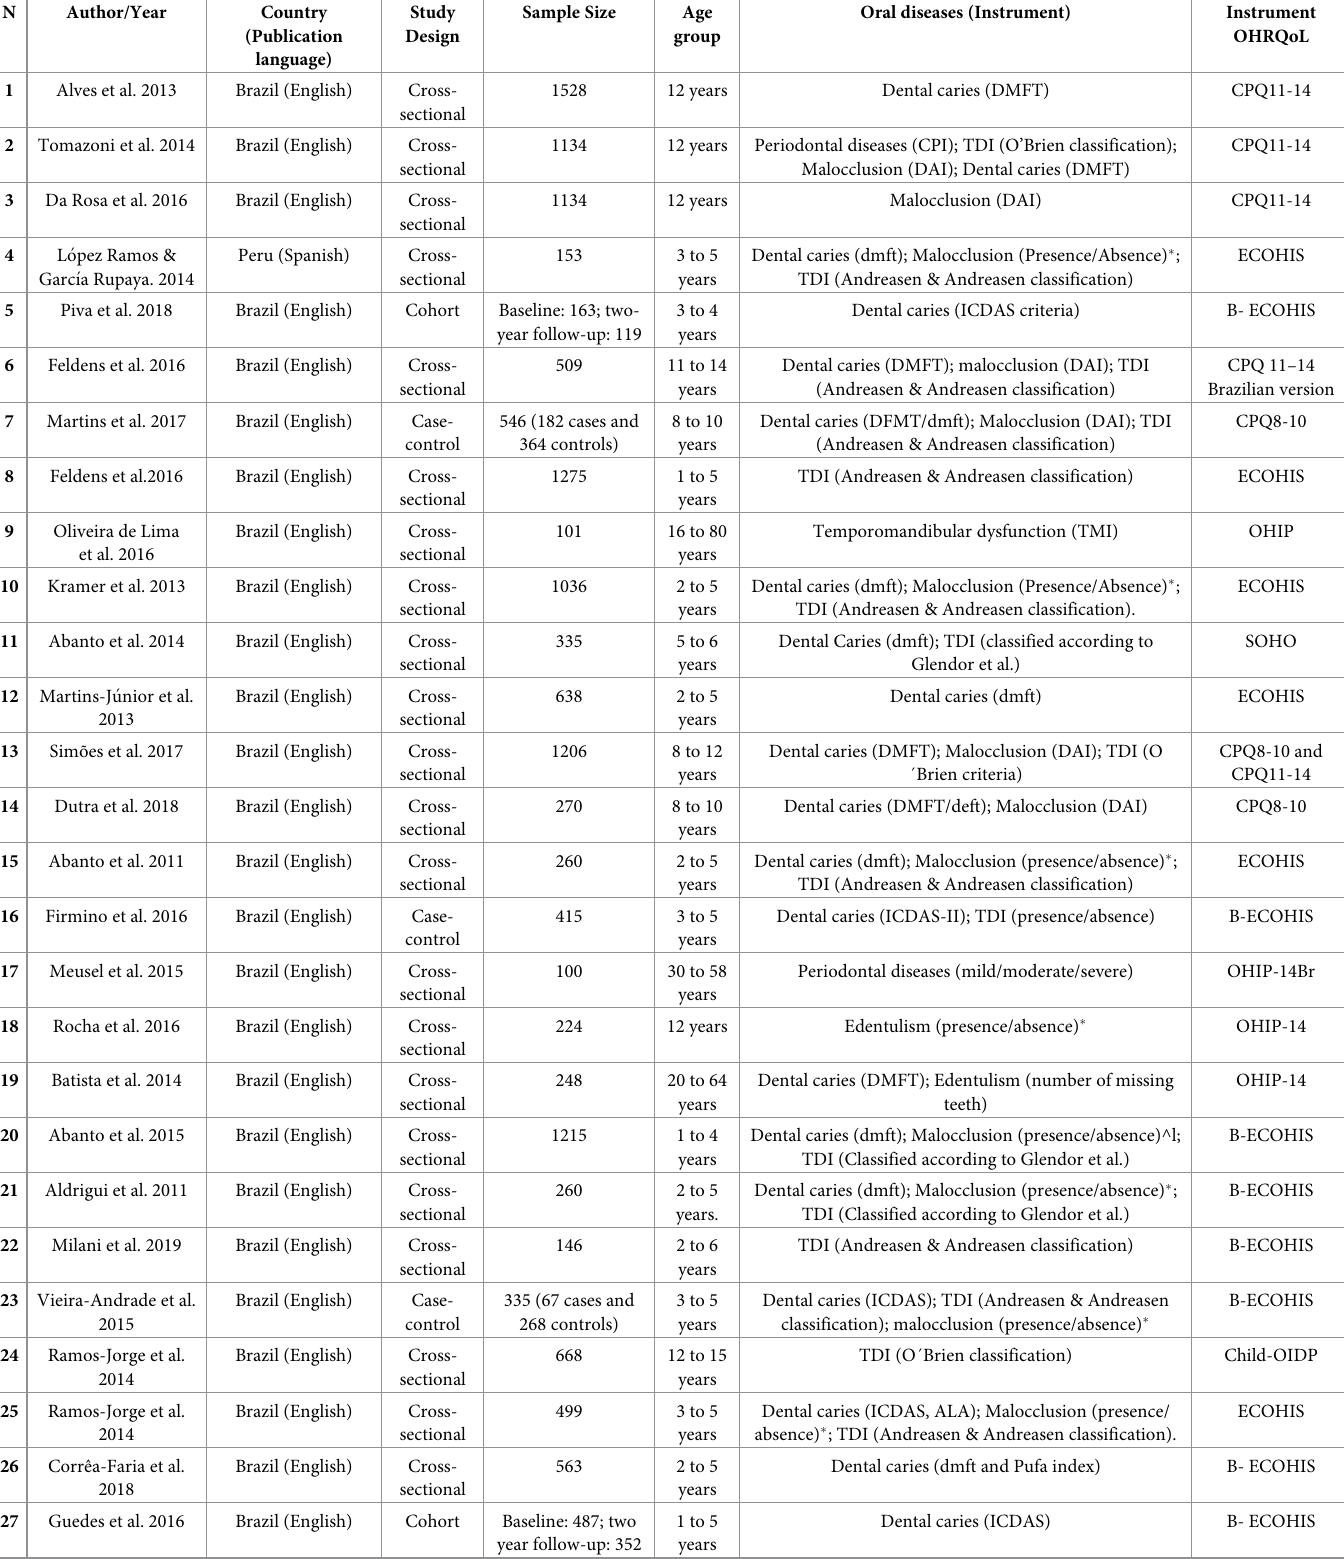
Table 1. Characteristics of the studies